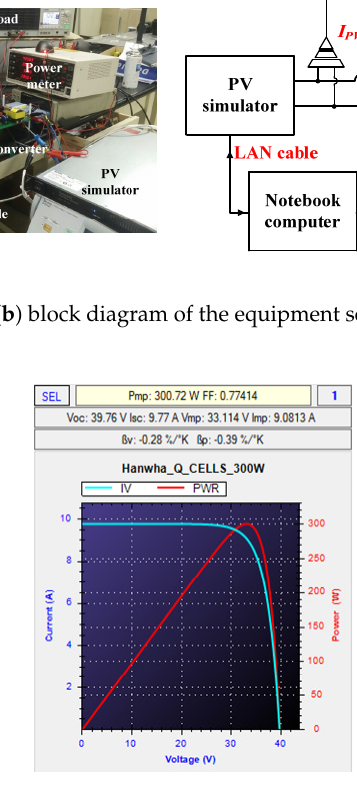
Figure 13. Electrical characteristic curve of a 300 W PV module “Q.PEAK-G4.1 300” under the standard test conditions (STC) of irradiance level of 1000 W/m 2 and module temperature of 25 °C. Table 4. Electrical characteristics of the PV module “Q.PEAK-G4.1 300” at different irradiance levels (E) and module temperatures (T).